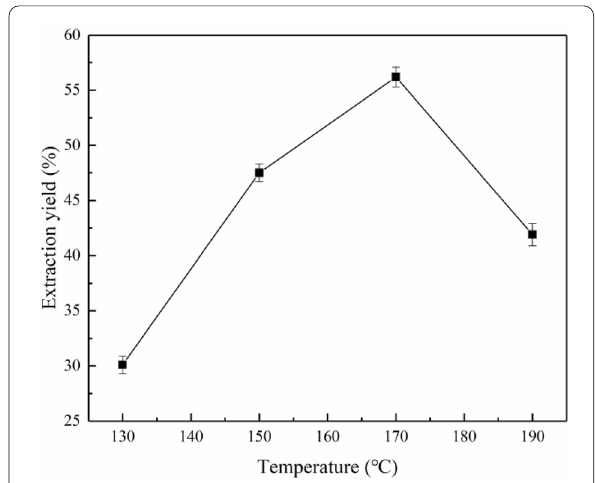
Fig. 4 Effect of the ethanol concentration on lignin extraction under the conditions of reaction time of 120 min, extraction temperature of 170 °C and solid/liquid ratio of 1:15